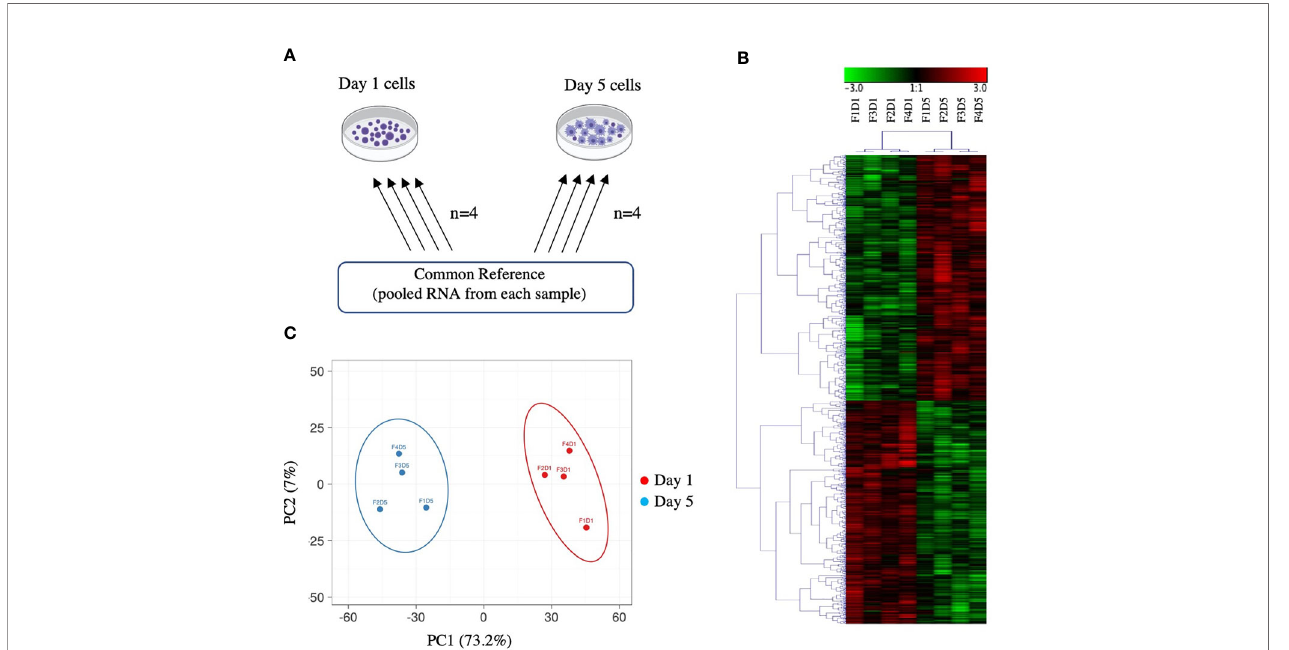
FIGURE 1 | Overview of microarray experimental design and global gene expression pro fi les. (A) Common reference-based microarray experimental design. Each arrow represents one array and identi fi es the samples co-hybridized on that array; the base of the arrow identi fi es the Cy3-labeled sample and the head of the arrow identi fi es the Cy5-labeled sample. (B) Hierarchical clustering analysis of 2140 DEPs in Day 1 and Day 5 HKLs identi fi ed by paired SAM (FDR 0.05). Complete linkage was performed on median-centred genes using a Pearson correlation. Green represents downregulation and red represents upregulation. F represents fi sh; D represents Day (i.e. F1D1 is Fish 1 Day 1). (C) Principal component analysis (PCA) of Day 1 and Day 5 samples based on DEPs identi fi ed by paired SAM (FDR 0.05). Day 5 samples are represented by blue, Day 1 samples are represented by red. The X and Y axis show principal component 1 (PC1) and principal component 2 (PC2) that explain 73.2% and 7% of the total variance,